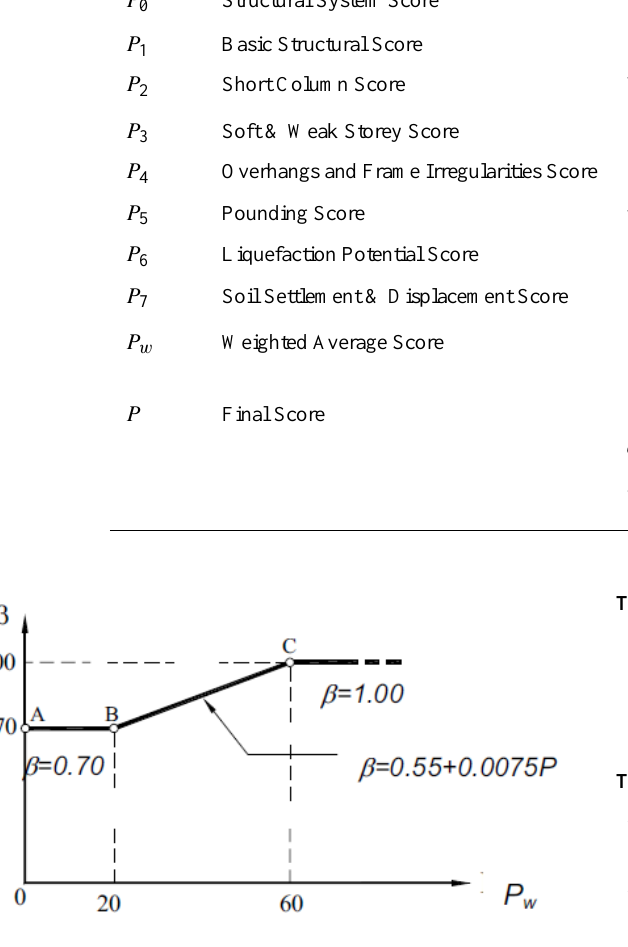
Fig. 7. β coefficient (Gulay et al., 2008). 4